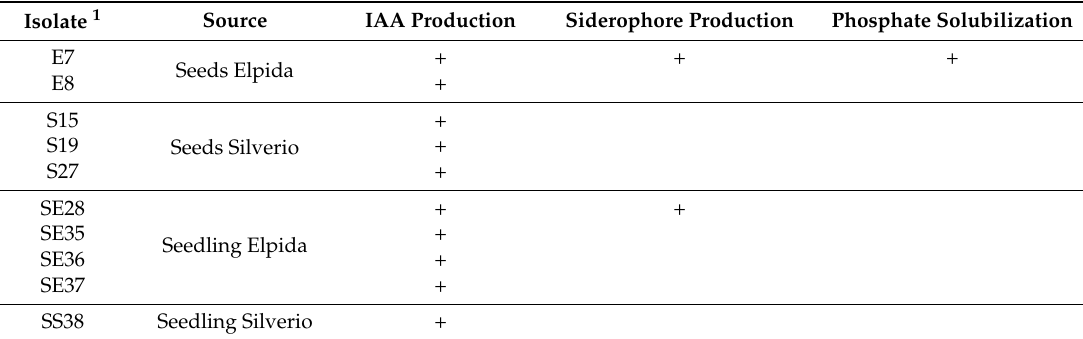
Table 6. Indolacetic Acid (IAA) and siderophore production and phosphate solubilization. Isolate 1